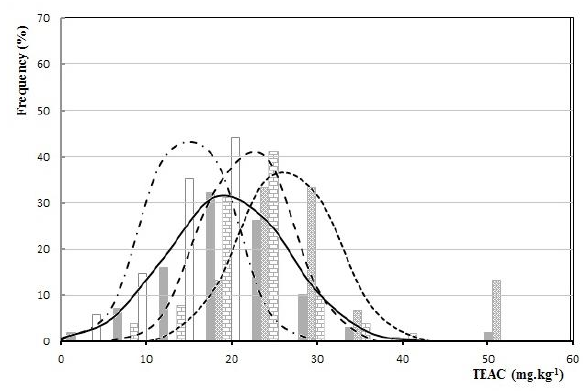
Figure 6: Distribution of antioxidant activity (ability to terminate DPPH radical) in oats expressed as Trolox equivalent antioxidant activity (solid column and solid line – complete set, r 2 = 0.987, bracket column and dash line – minor, red subset, r 2 = 0.888, dots column and dash-and-dot line – major, green subset, r 2 = 0.982, empty column and dots line – major, blue subset, r 2 = 0.929, the mentioned colors correspond to the colors in Fig. 2 and Fig. 3).